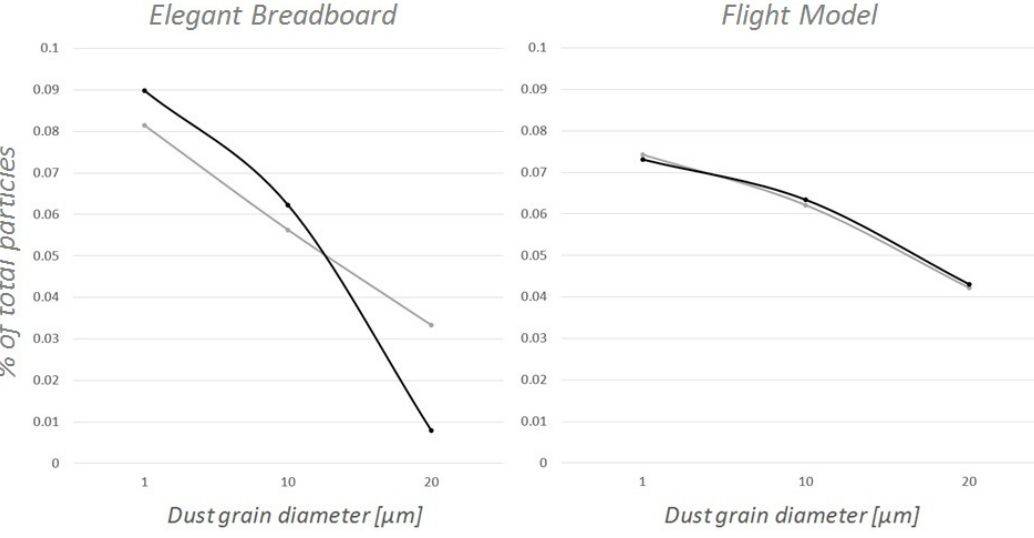
Figure 10. Comparison between the Elegant Breadboard’s and the Flight Model’s ability to correctly deduce size distribution (GRAY: real distribution, BLACK: measured distribution).